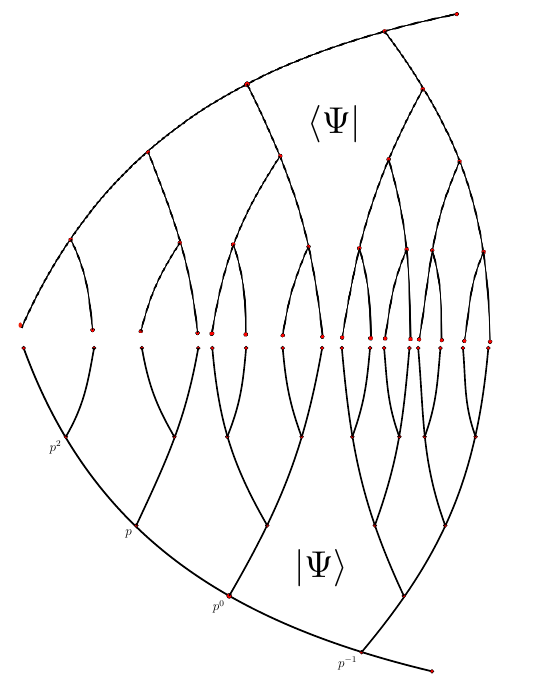
Figure 2. The tensor network of [1] is interpreted as the wavefunction of p -adic CFT. Correlation functions are computed by gluing the tensor network and its conjugate along their cuto(cid:11)